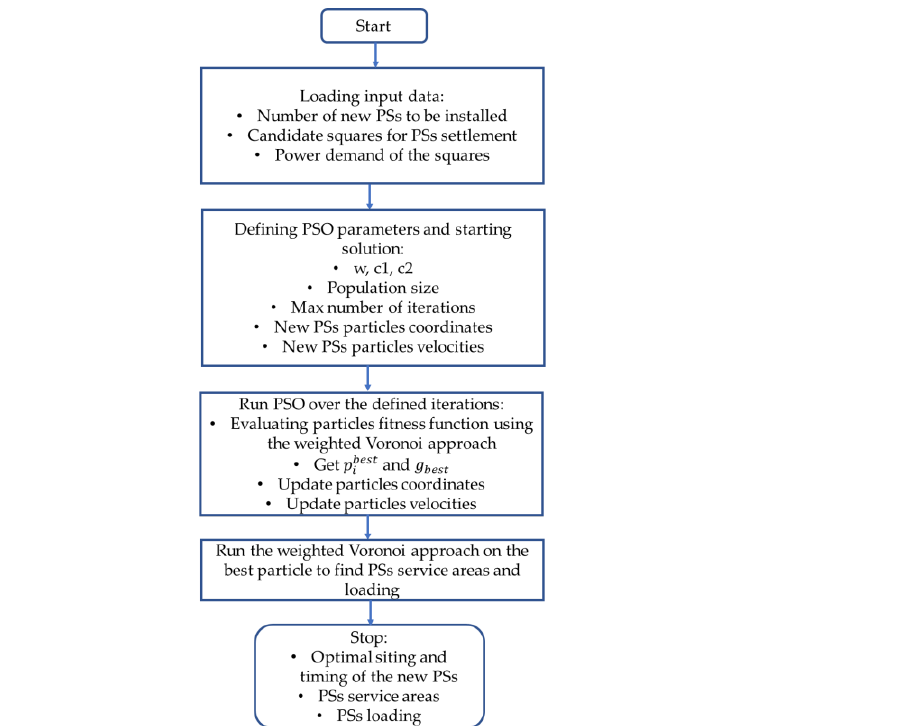
Figure 16. Flowchart of the optimization approach.